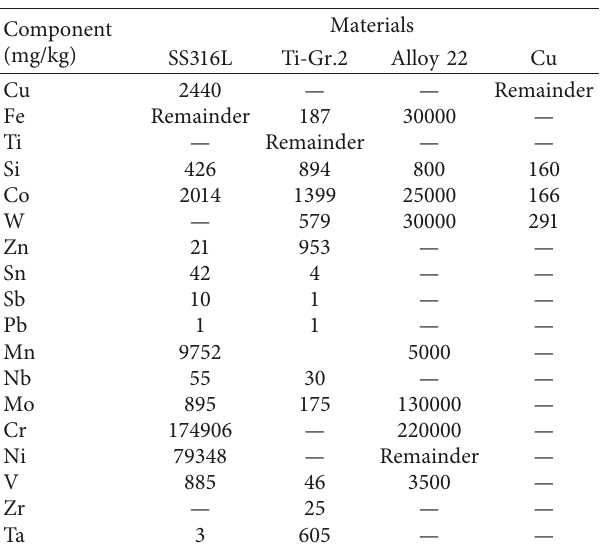
Table 1: Chemical compositions of test materials used in this study.